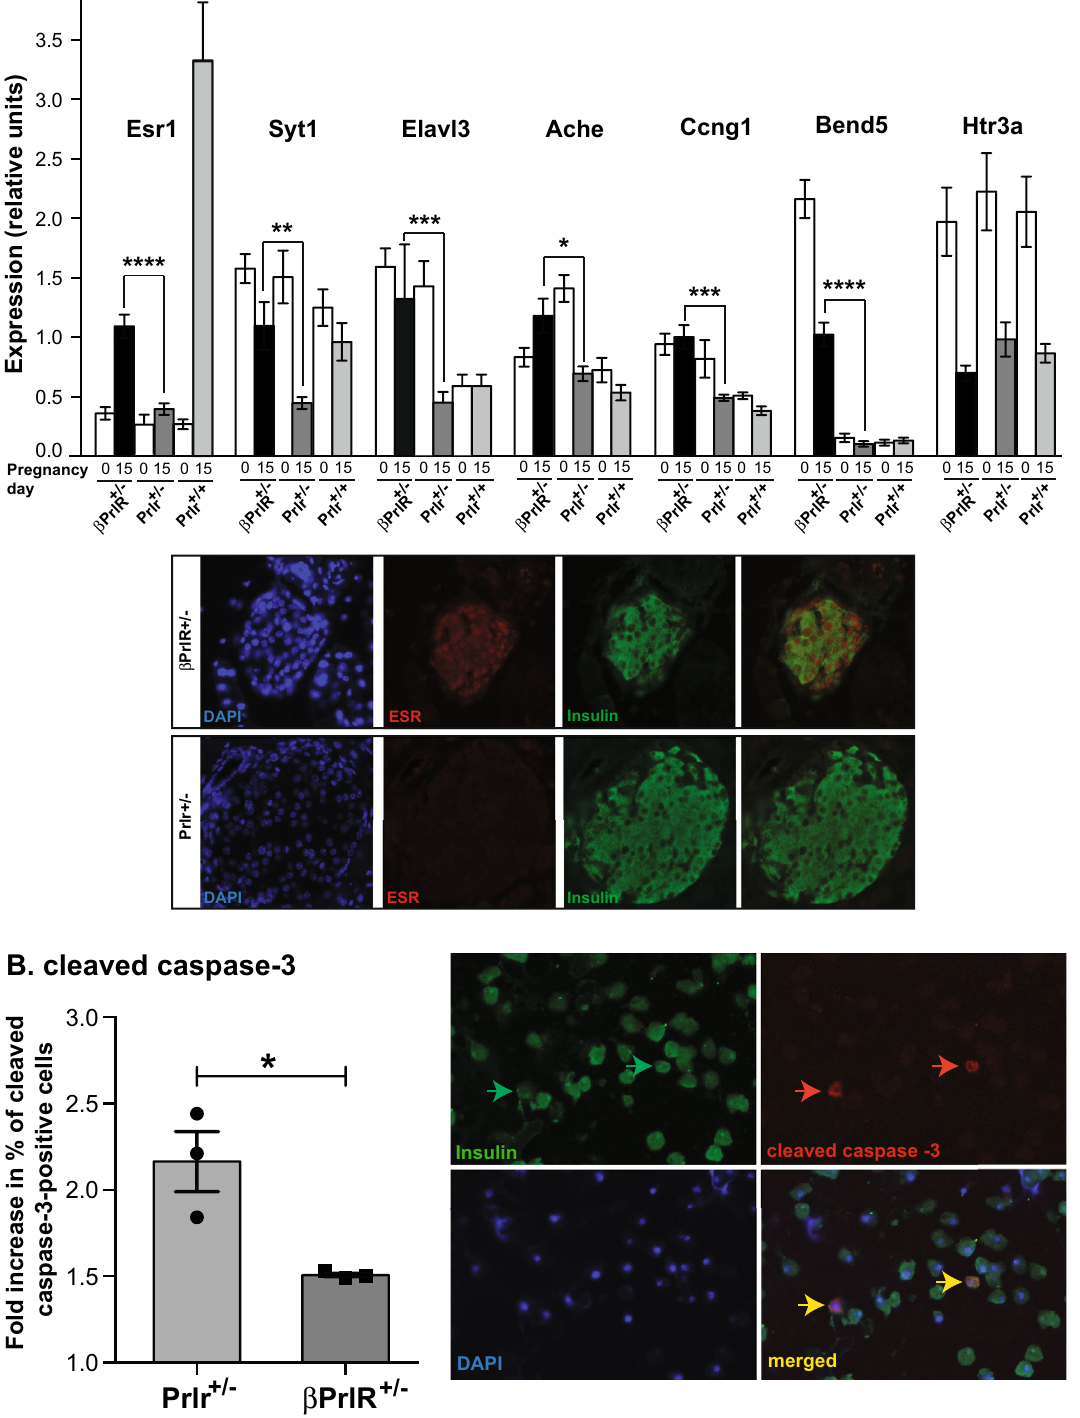
Figure 5. Pancreatic islets from pregnant Prlr +/− mice are more susceptible to apoptosis than those from βPrlR +/− mice. ( A ) Gene expression was determined by RT-qPCR in islets from non-pregnant and pregnant (day 15) βPrlR +/− , Prlr +/− and Prlr +/+ mice. N = 6–13 mice per genotype at day 0 or day 15 of pregnancy. “****” = p < 0.001, “***” = p < 0.005, “**” = p < 0.01, and “*” = p < 0.05. Representative images of β-cell and ERα co-staining in an islet in βPrlR +/− or Prlr +/− mouse are presented. ( B ) Islets from day 15 pregnant Prlr +/− and βPrlR +/− mice were treated with 0.5 mM of palmitate or BSA control for 72 h, then immunostained for insulin and cleaved caspase-3. Results are expressed as the fold-increase in the percentage of cleaved caspase-3 positive β-cells in the palmitate-treated islets relative to the BSA-treated islets within each genotype. N = 3 mice from each genotype. At least 5000 cells were counted for each mouse. “*” = p < 0.05 in comparison to Prlr +/− mice. A representative image of cells stained for insulin (green), cleaved caspase-3 (red), and nuclear stained with Hoechst is presented. The two yellow arrows in the right lower panel points to two cells that are positive for both insulin (green, upper left panel) and cleaved caspase-3 (red, upper right